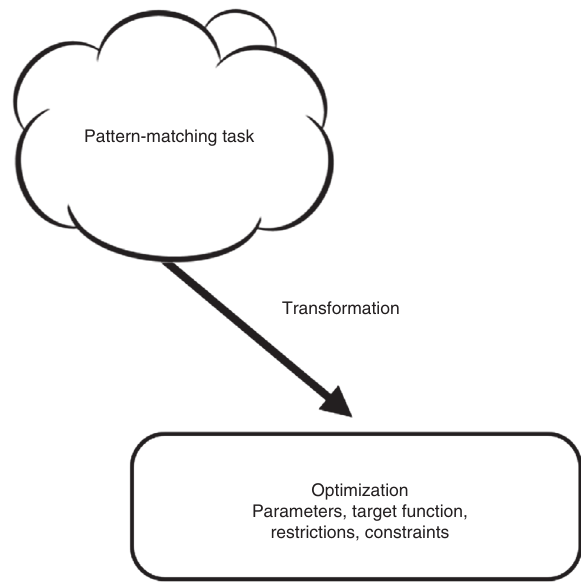
Figure 1. Informal-to-Formal